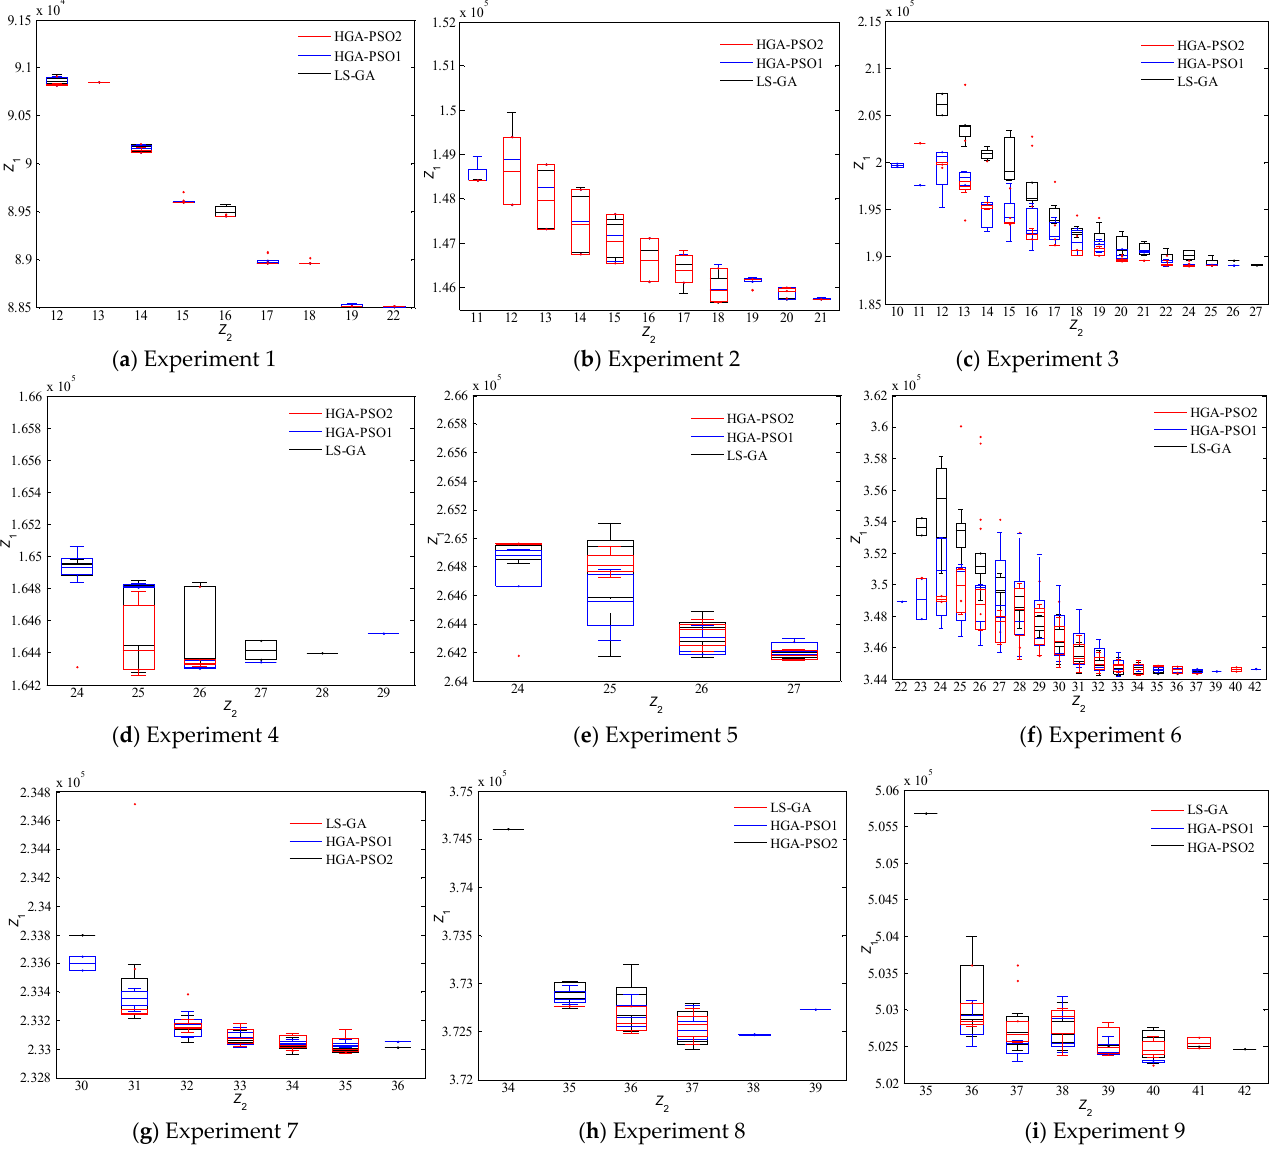
Figure 14. Comparison of calculation results for three strategies.